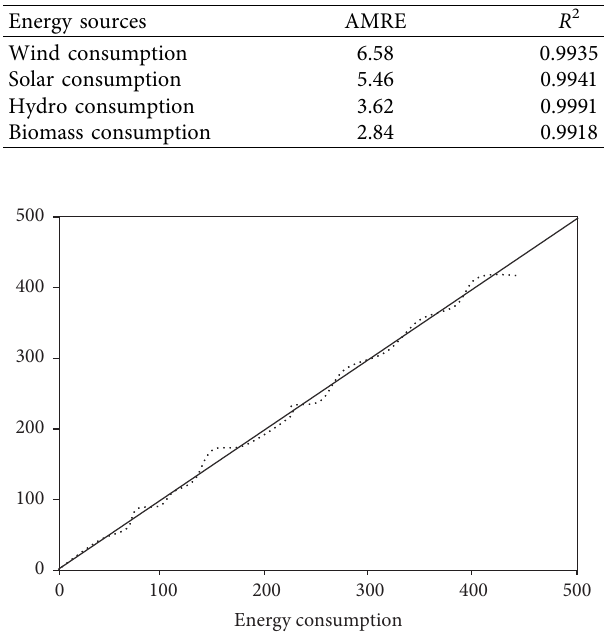
Table 2: Absolute mean square error and absolute fraction variance for renewable energies in the DNN.